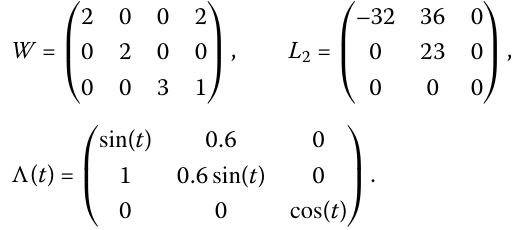
Figure 12 Time series of the synchronization error